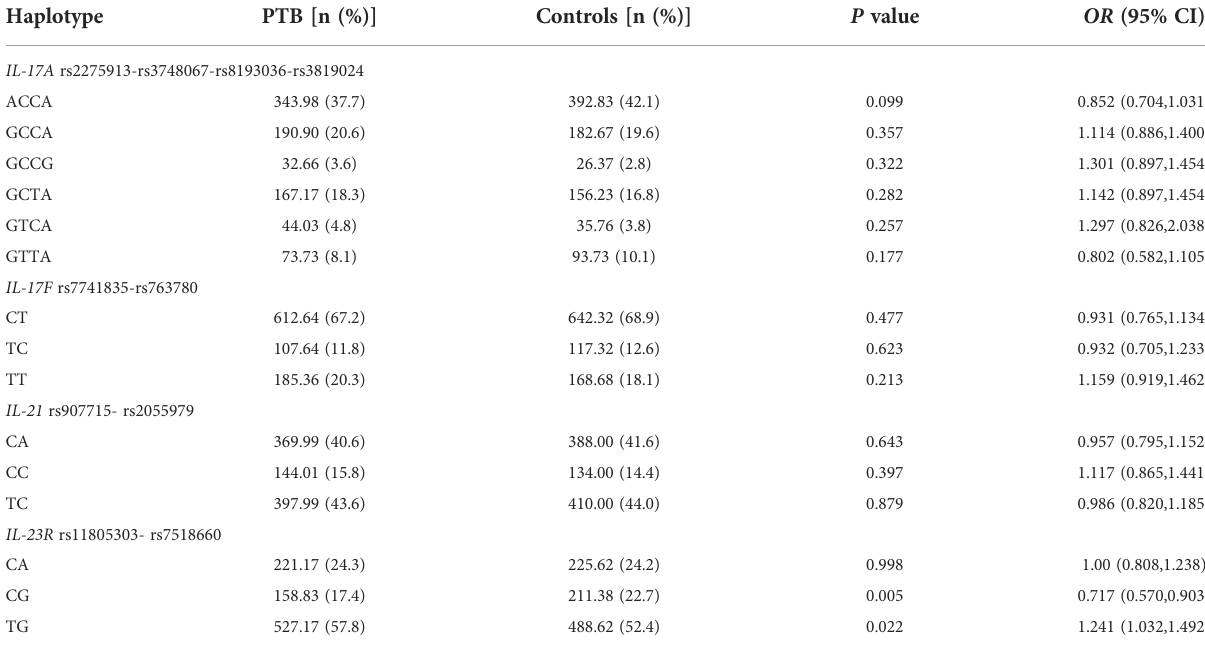
TABLE 3 Haplotype analysis of Th17 pathway genes in PTB patients and controls.